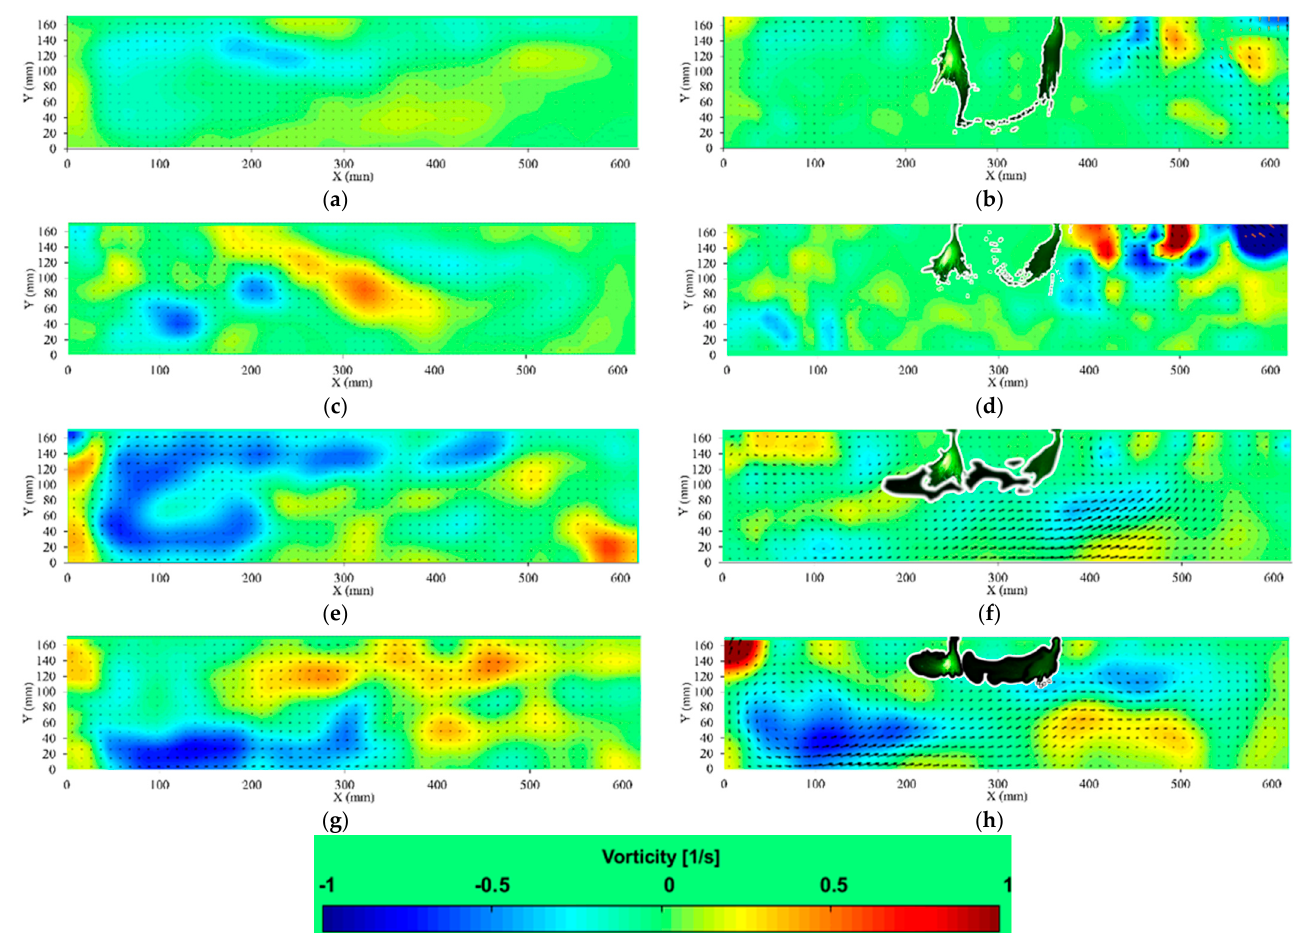
Figure 7. Vorticity distribution of the flow field in hydroponics in different flow rates. ( a ) 2 L/min (without plants); ( b ) 2 L/min (with plants); ( c ) 4 L/min (without plants); ( d ) 4 L/min (with plants); ( e ) 6 L/min (without plants); ( f ) 6 L/min (with plants); ( g ) 8 L/min (without plants); ( h ) 8 L/min (with plants). The magnetic map of vorticity is shown in the figure, green means no vorticity, red means clockwise vorticity, and blue means counter-clockwise vorticity.